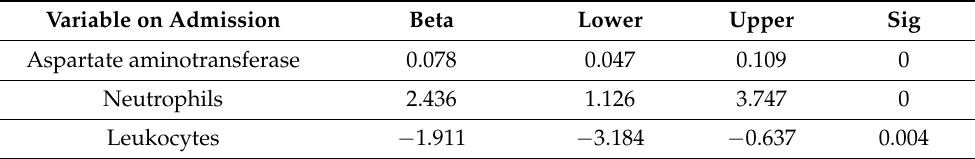
Table 1. Regression model for CT scan severity score. Variable on Admission